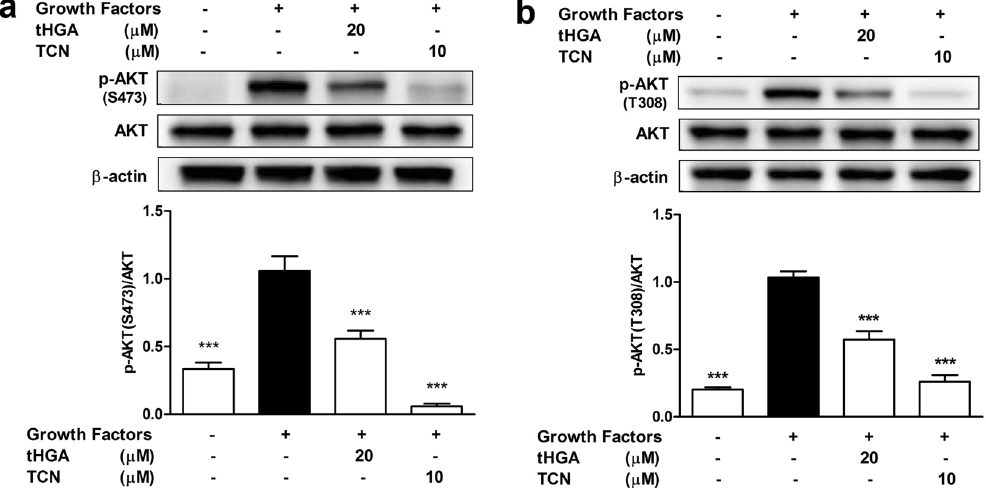
Figure 5. Effects of tHGA on the phosphorylation of AKT in growth factor-induced hBSMCs. hBSMCs were serum-starved overnight before co-treatment with growth factors and tHGA or triciribine (TCN) for 1 hour. Phosphorylation of ( a ) AKT (Ser473) and ( b ) AKT (Thr308) in growth factor-induced hBSMCs upon tHGA treatment were assessed through immunoblotting. Proteins were immunoblotted with respective antibodies and the protein bands were quantified by densitometry. Results of ( a ) phospho-AKT (Ser473) and ( b ) phospho-AKT (Thr308) were presented after normalization with total AKT. Representative cropped blots are presented (full-length blots are presented in Supplementary Fig. S4). Results are presented as mean ± SEM of 3 independent experiments. * P < 0.05, ** P < 0.01 and *** P < 0.001, significantly different from growth factor induced-hBSMCs. TCN: